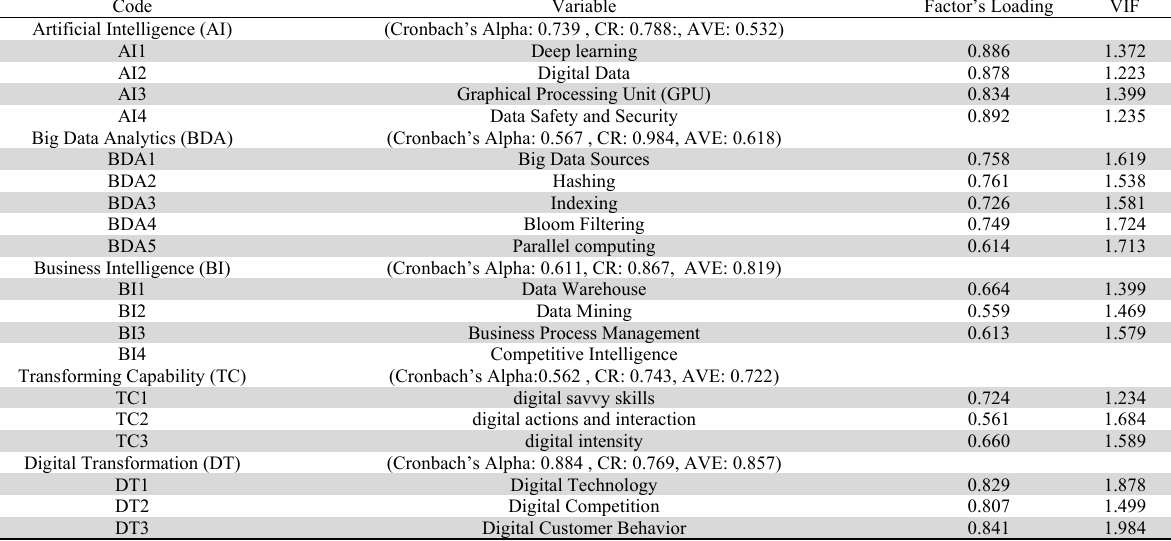
The summary of the reliability and validity